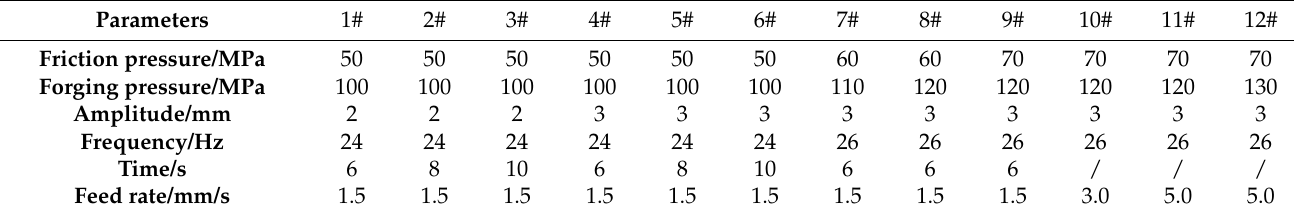
Table 2. Welding parameters for Ti 2 AlNb-based